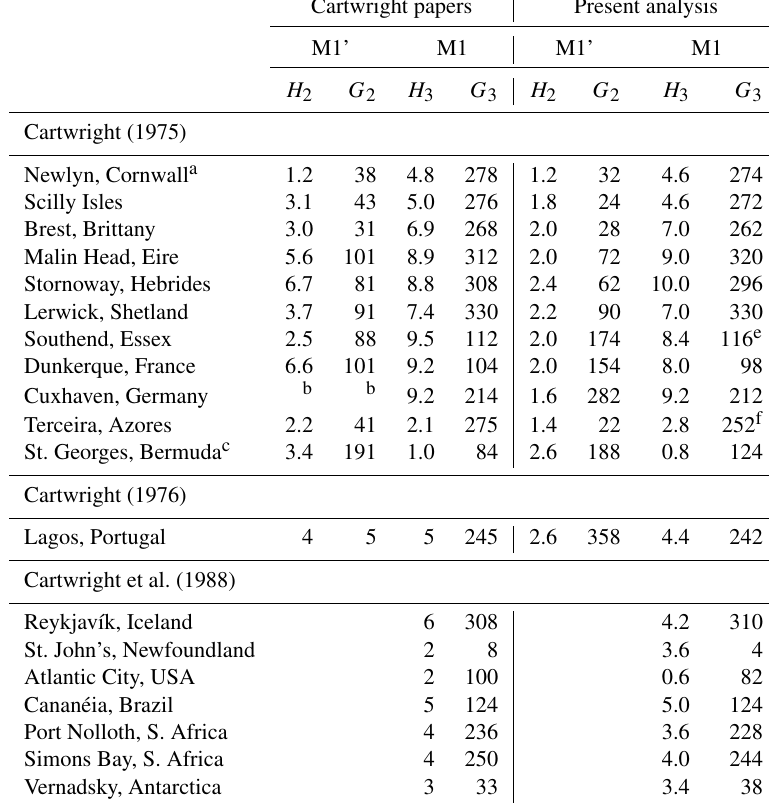
Table 2. Amplitudes (mm) and Greenwich phase lags ( ◦ ) for M1’ and M1 as reported in Cartwright (1975, 1976) and Cartwright et al. (1988). Figure 5 of the latter shows M1 values for 13 stations, of which 6 had been reported in the earlier papers. In the right-hand columns are the corresponding values obtained in the present analysis. d Cartwright papers Present